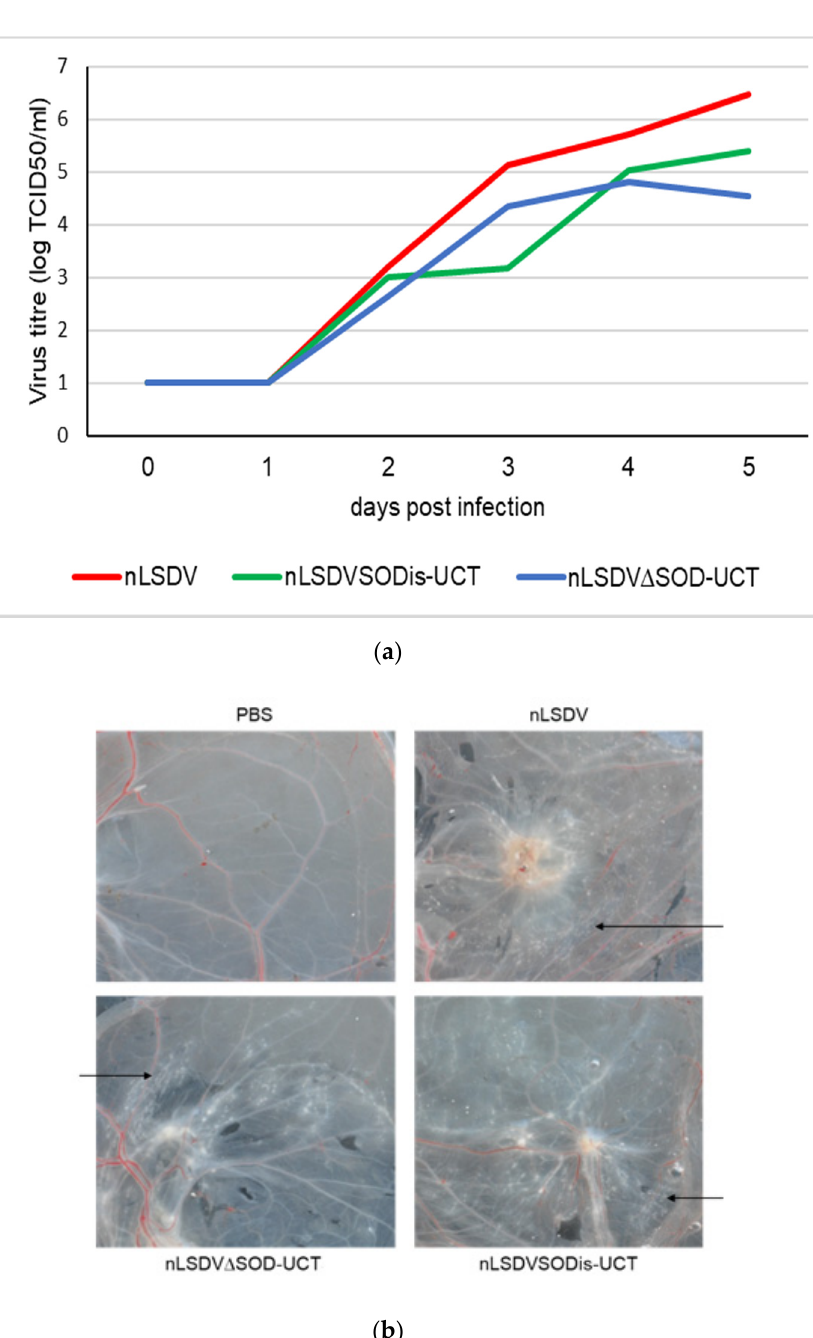
Figure 4. Growth in fertilized 7 day old hens’ eggs. ( a ) Growth curves of nLSDV, nLSDV ∆ SOD-UCT and nLSDVSODis-UCT on chick chorioallantoic membranes (CAMs) of fertilized hens’ eggs. First, 7 day-old fertilized hens’ eggs were infected with virus at 10 3 TCID50 per egg and incubated at 34 °C. Eggs were harvested daily from days 0 to 5, triplicate membranes were pooled, and crude virus extracts were titrated in triplicate. The data shown are mean values of titers, expressed as TCID50/mL. The triplicate values were too close to show error bars. ( b ) Macroscopic appearance of infected CAMs on day 5 post infection. Representative images are shown. Black arrows point towards pocks.